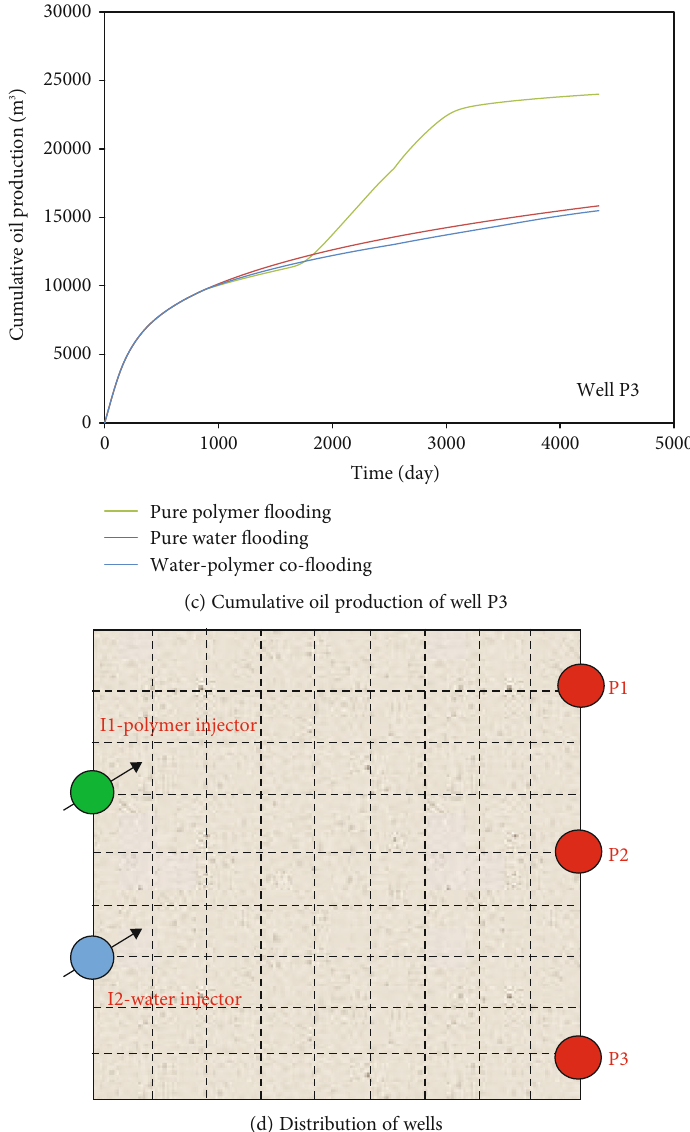
Figure 9: Cumulative oil production of wells in di ff erent